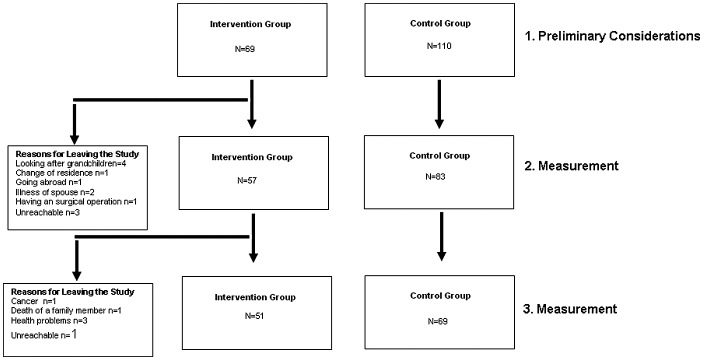
Consort diagram (cont.).